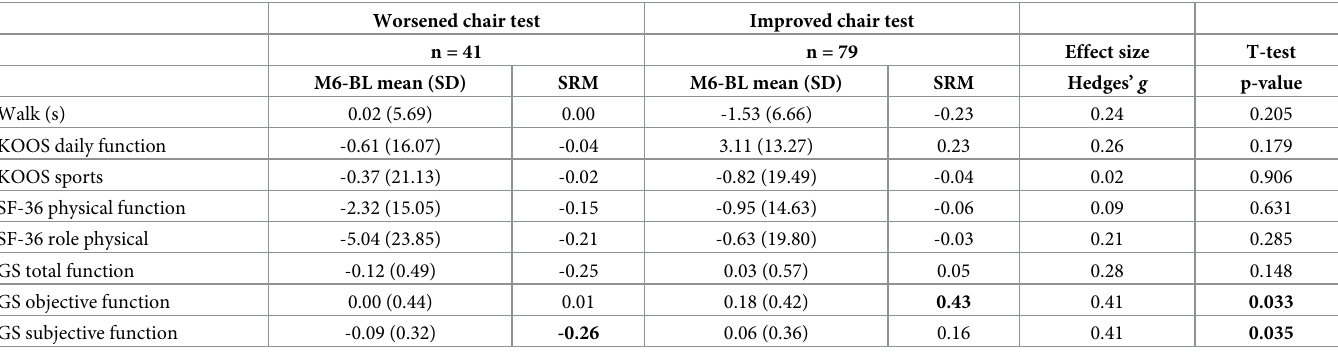
Table 5. Standardized response means and effect sizes of different functional outcome measures in subgroups based on MDC (= 2) of the 30s chair stand up